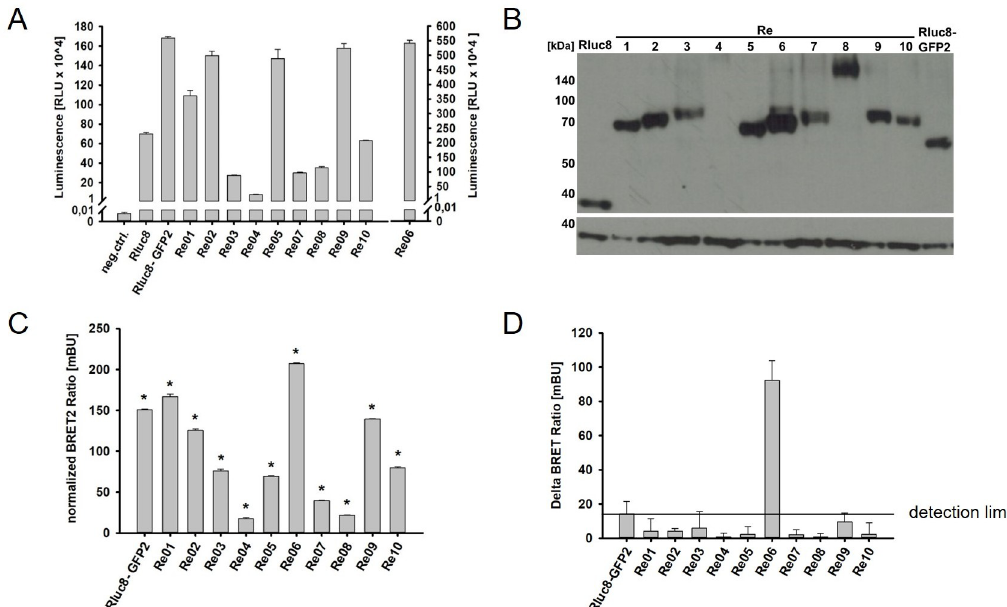
Fig 3. Characterization of eBRET2 biosensor expression after the deletion of the splice site. (A) Luciferase activity via Luminescence measurement. Rluc8 expression correlates with Luciferase activity. (B) Western Blot shows full length expression of the biosensors, correction factor (Rluc8 alone) and maximum control Rluc8 GFP2. 1. Antibody: anti Rluc8 (1:1000) on the top and anti GAPDH (1:1000) on the bottom. 2. Antibody: anti Rabbit HRP (1:12000). (C) eBRET2 ratios of the biosensor variants normalized with the correction factor (Rluc8 30.1 ± 0.1 mBU). Significance defined as p < 0.001. (D) Delta eBRET2 ratios after incubation with 10 ng VEGF. Change in Δ BR of the maximum control (Rluc8 GFP2) was set as detection limit, marked with the